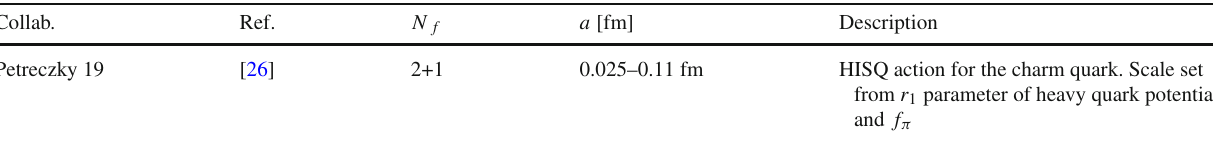
Table 96 Continuum extrapolations/estimation of lattice artifacts in the determinations of m b with N f = 2 + 1 quark flavours Collab.